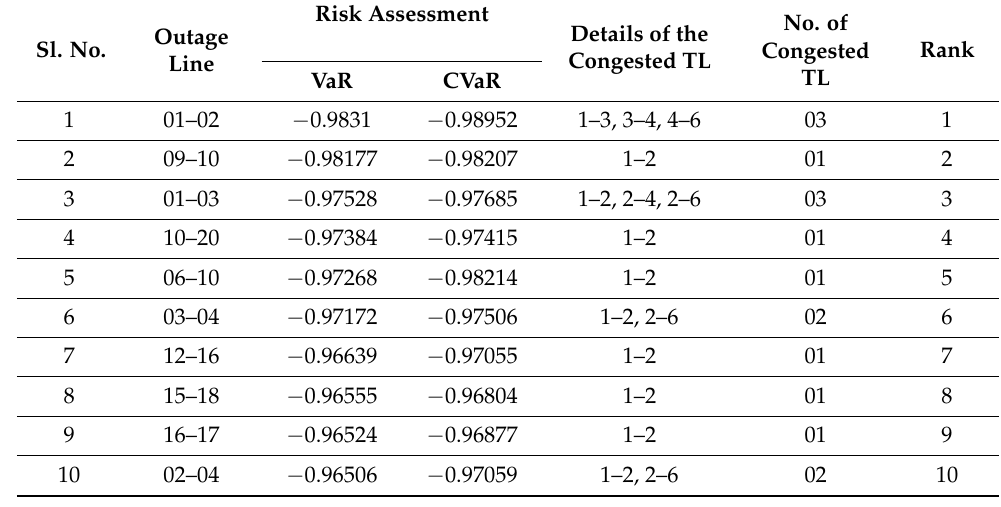
Table 4. System risk and congestion in the IEEE 30-bus system.